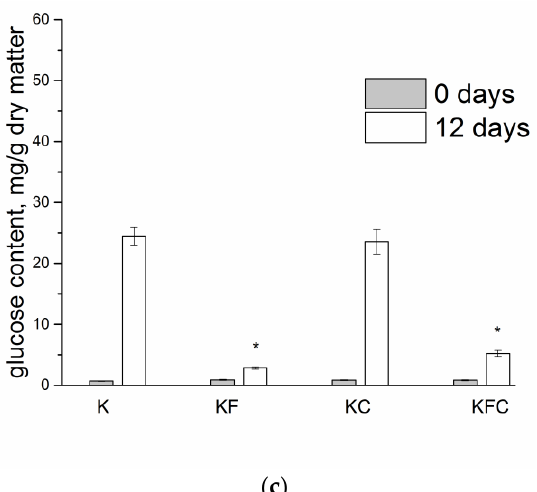
Figure 4. The sugar content of kombucha (K — control, KF — kombucha with algae extract, KC — kombucha with lichen extract, KFC — kombucha with a mixture of algae and lichen extracts): ( a ) sucrose content at 0 and 12 days of fermentation, ( b ) fructose content of kombucha samples at 0 and 12 days of fermentation, ( c ) glucose content of the kombucha samples at 0 and 12 days of fermenta- tion. * Significantly different from sample K, * p < 0.05.